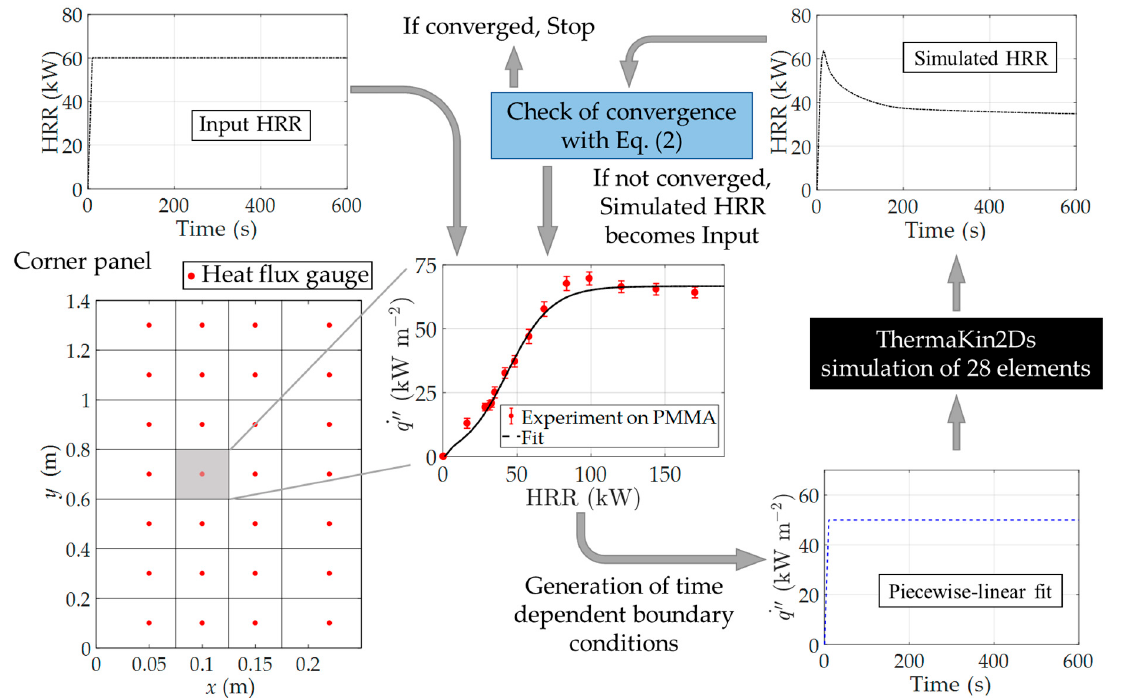
Figure 2. Workflow diagram for the corner wall flame spread modeling. Note that the heat flux gauge locations shown here represent locations from a previous study performed on PMMA [32].